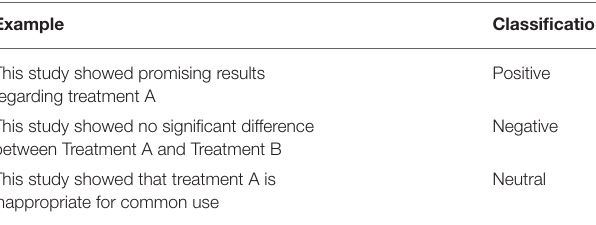
TABLE 1 | Examples of positive, negative, and neutral text in